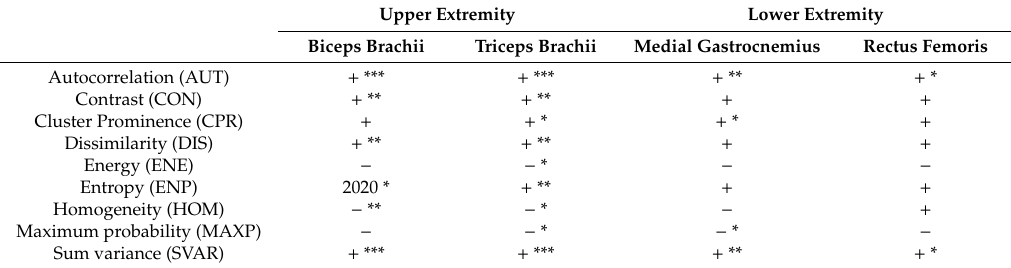
Table 2. Comparison of muscle texture parameters in dynapenia without